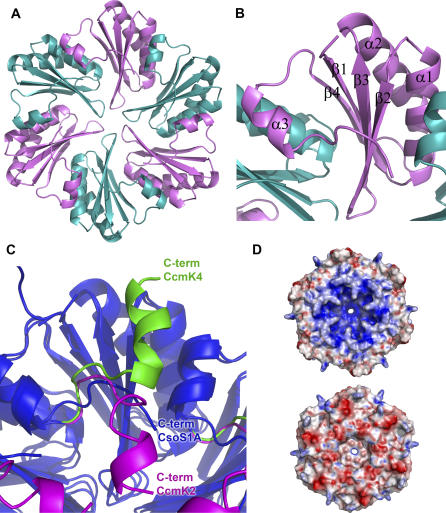
Structure of the CsoS1A Hexamer That Forms the Building Block of the Alpha Type Carboxysome Shell(A) A ribbon diagram with the monomeric units colored alternately in purple and teal.(B) A close-up of the CsoS1A monomer in the hexamer. Secondary structures are labeled and numbered.(C) An illustration of the differing C-terminal configurations of carboxysome shell proteins: CsoS1A (blue), CcmK2 (pink), and CcmK4 (green). The differences between the structures are apparent after residue 91, with the C-terminus of CsoS1A intermediate in position compared to the termini of CcmK2 and CcmK4.(D) An illustration of the geometric and electrostatic differences between the concave (top) and convex (bottom) sides of the CsoS1A hexamer. The concave side of CsoS1A is composed of mostly positive electrostatic potential (blue), whereas the convex side is composed of mostly negative electrostatic potential (red).